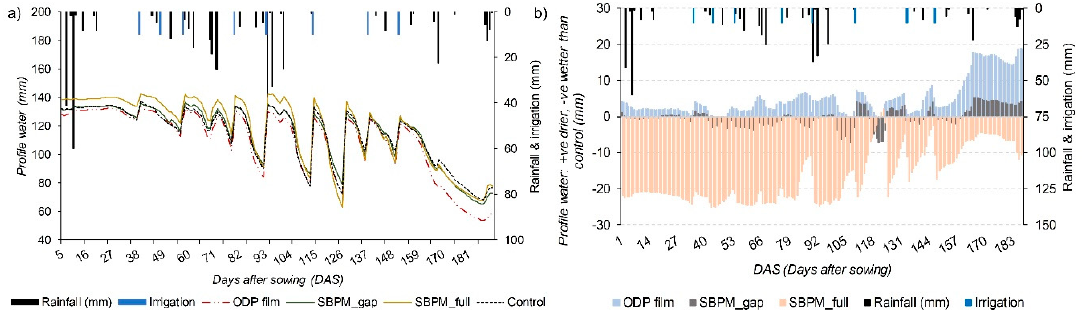
Figure 3. ( a ) The e ff ect of oxo-degradable plastic (ODP) mulch film and sprayable biodegradable polymer membrane (SBPM_gap and SBPM_full) treatments on cumulative soil profile water content (mm) during the cotton growing season 2015 / 2016 at the ACRI field site ( n = 10 plots; SBPM_full not replicated); ( b ) the comparison of soil profile water under the ODP, SBPM_gap and SBPM_full treatments, shown in relation to the control: positive is drier and negative is wetter than the control.